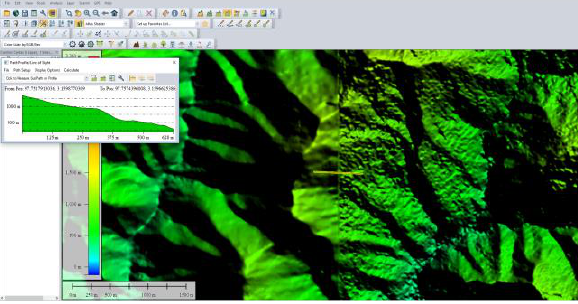
Figure 10. Visualization of DEM National in the same location with Figure 2